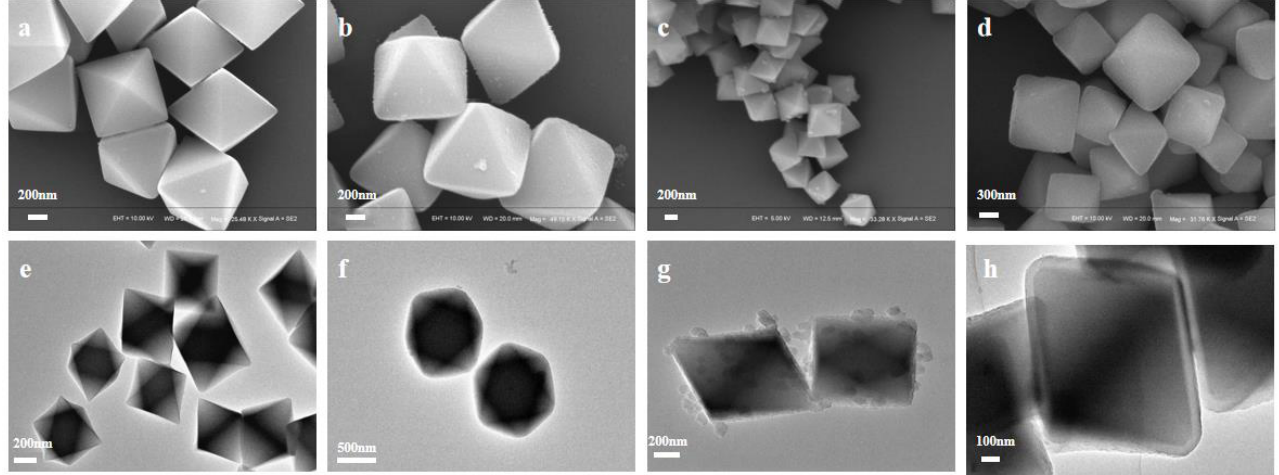
Figure 1. SEM and TEM imaging of ( a , e ) UiO-66-NH 2 and ( b , f ) UiO-66-NH 2 @PDA, where the DA concentration is 0.1 mg·mL −1 ; ( c , g ) UiO-66-NH 2 @PDA, where the DA concentration is 0.25 mg·mL −1 ; and ( d , h ) UiO-66-NH 2 @PDA, where the DA concentration is 0.5 mg·mL −1 .